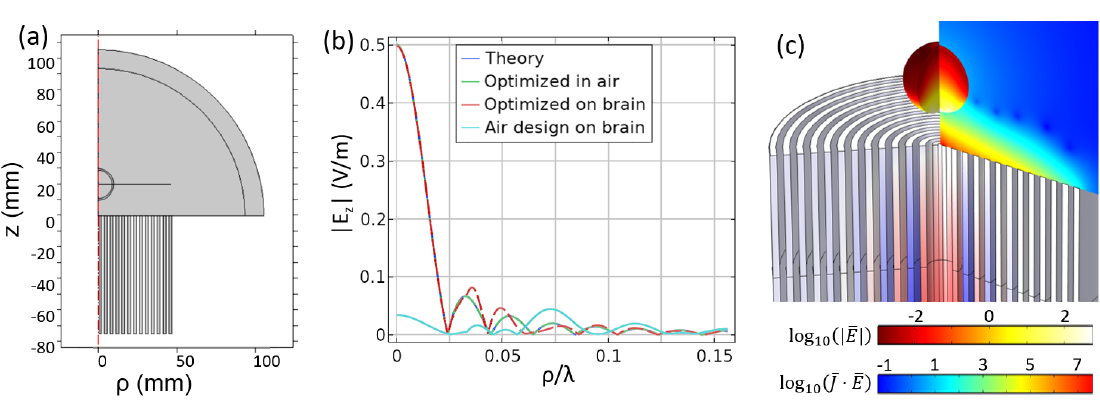
Figure 7. ( a ) A slice of the axisymmetric geometry, ( b ) the field in the focal plane, ( c ) and full field ( (cid:126) J · (cid:126) E ), in the biological tissue; a slice of results. For the isometric view, we show Ohmic heating, log 10 ( | (cid:126) E | ) , in the air between the grooves and target; and a measure of the H-field, the electric field, log 10 ρ · H φ in the grooves. Note that the color bars are Ohmic heating (left) and E-field (right), but we do not show a color bar for the grooves so as not to clutter the figure. The relevant H-field information is that the phase oscillates from groove to groove and the amplitude vs. radius decays faster than